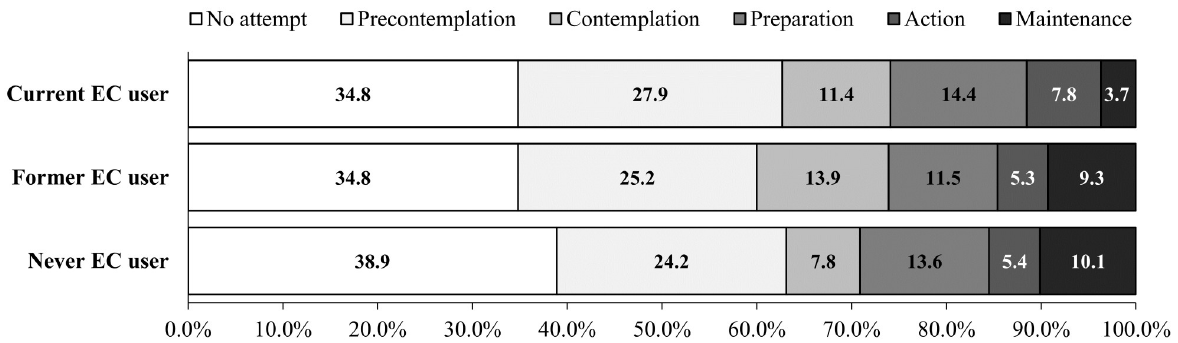
Fig 2. Prevalence of the stages of change in cigarette smoking cessation by e-cigarette use status. This is a stacked bar graph showing the distribution of percentages of cessation stages among current (n = 353), former (n = 881), and never (n = 2,695) e-cigarette users. EC =